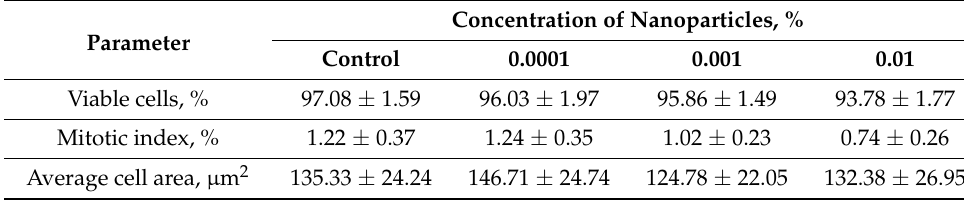
Table 6. The effect of a colloidal solution of zinc oxide nanoparticles on the growth and development of cells. Concentration of Nanoparticles, % Parameter